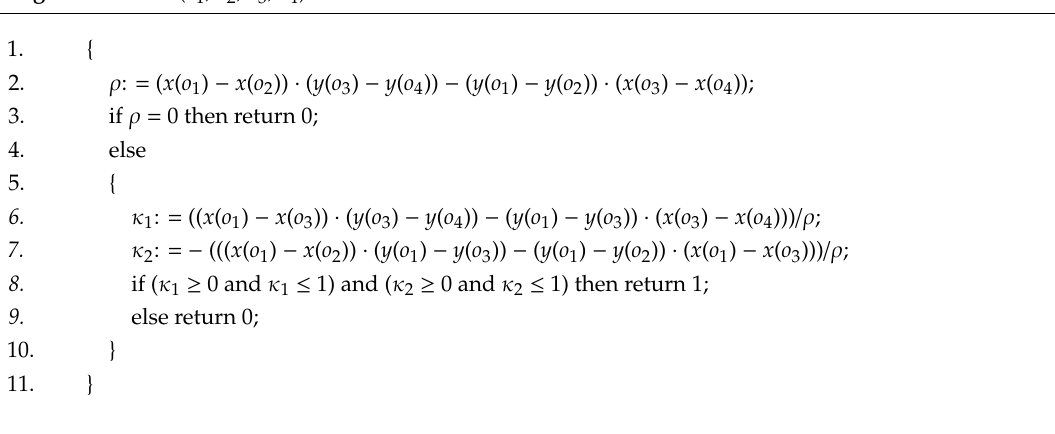
Algorithm 1 EEI ( o 1 , o 2 , o 3 , o 4 )